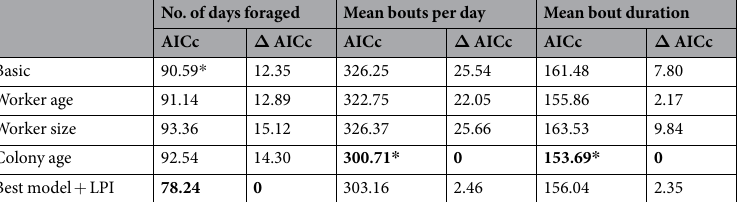
Table 2. Candidate models to predict the number of days foraged, the mean number of bouts per day and mean bout duration. The basic model contained only the intercept and colony membership as a random factor. All other models contained the basic model and the additional fixed factors (predictors) specified in the model name. The model with the lowest AICc value out of the five initial models (indicated with an asterisk) had learning performance (LPI) added to it to determine whether this significantly decreased the AICc value (i.e. Δ AICc > 2). The best model (based on the AICc value) is shown in